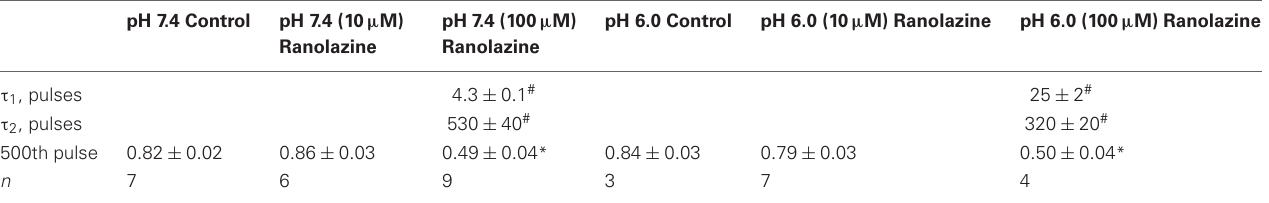
Table A6 | Use-dependence 1Hz.